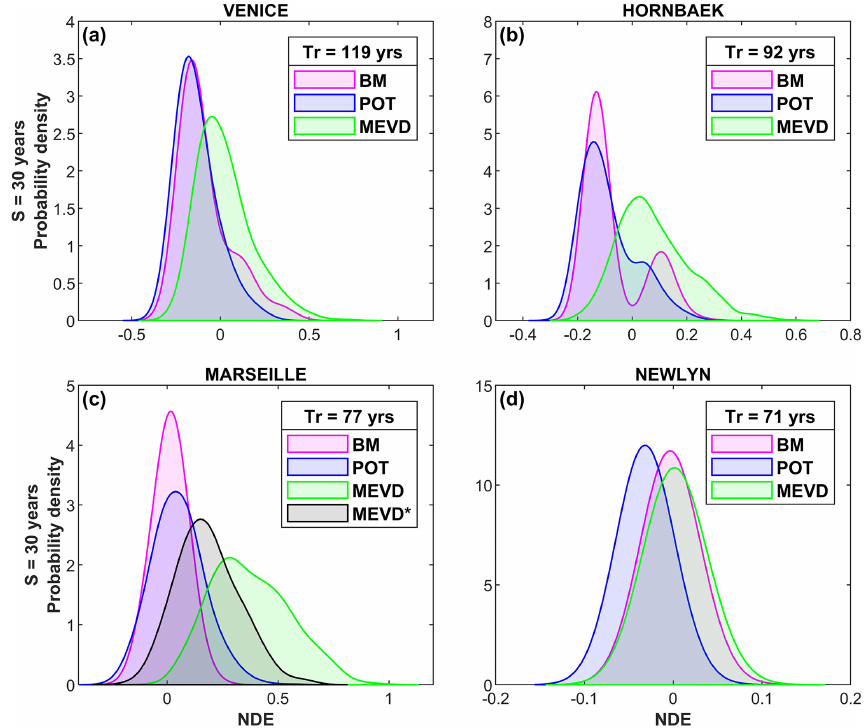
Figure 5. Kernel density estimates for the nondimensional error (NDE) distributions obtained with a calibration sample size ( S ) of 30 years and maximum return period ( T r ) at given gauge stations explored: (a) Venice (IT), (b) Hornbæk (DK), (c) Marseille (FR), (d) Newlyn (UK). In the case of the Marseille (FR) site, MEVD parameter estimation is based (1) on non-overlapping sub-samples of fixed size (5 years; green color) and (2) on data from the whole calibration sample (black color).